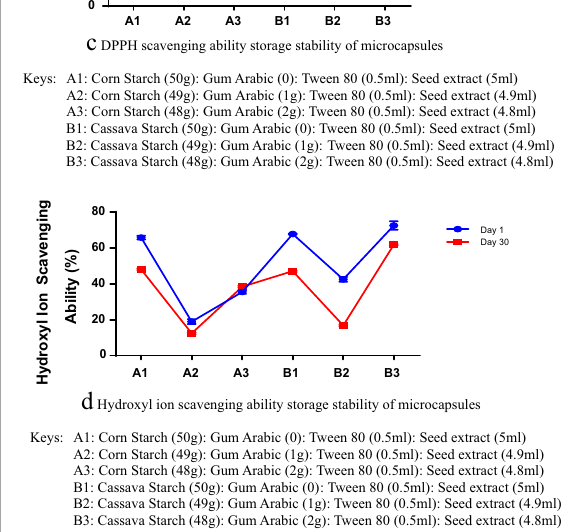
c DPPH scavenging ability storage stability of microcapsules